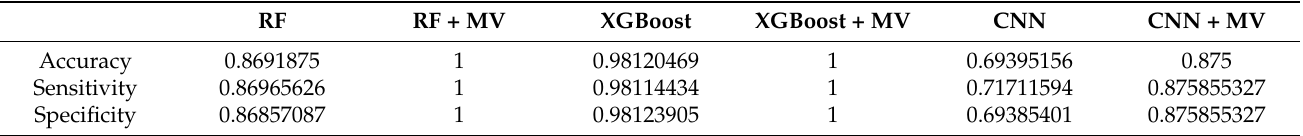
Figure 6. Classification performance, tubers differentiation phenological stage using two classes. Table 1 compares the classification performance using the best three classifiers found: RF, XGBoost, and CNN alone and using Majority Voting (MV). This table shows that both RF and XGBoost correctly classify all the images using majority voting, followed by CNN. Table 1. Comparison of classification performance of RF, XGBoost, and CNN alone and using MV for tubers differentiation phenological stage using two classes.